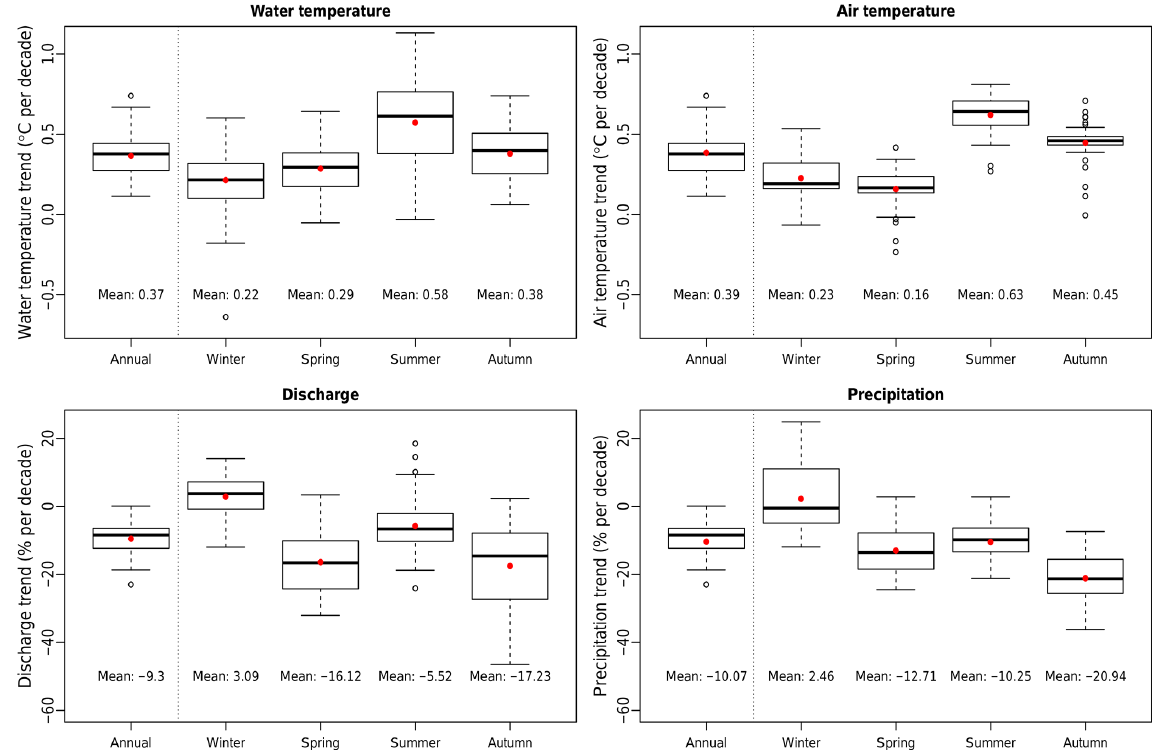
Figure 10. Annual and seasonal trends for water temperature, air temperature, discharge, and precipitation for the 1999–2018 period. The mean values are indicated by red dots and written below the boxes in degrees Celsius per decade or percent per decade. Table 3. Correlation between the annual and seasonal time series of water and air temperature (left), water temperature and discharge (middle), and discharge and precipitation (right). Correlations are computed for all 52 individual catchments over the 1999–2018 period and then averaged over all catchments. Numbers in parentheses indicate the number of catchments where the correlation is not significant ( p value > 0.05, with the null hypothesis being no correlation). Water and air Water temperature Discharge and temperature and discharge precipitation Period Correlation Period Correlation Period